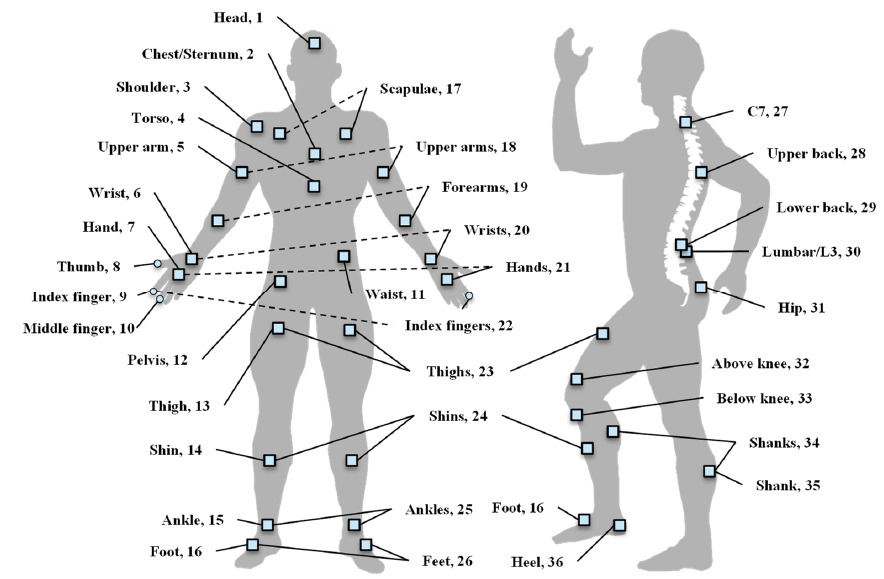
Figure 3. Distribution of the sensor locations.